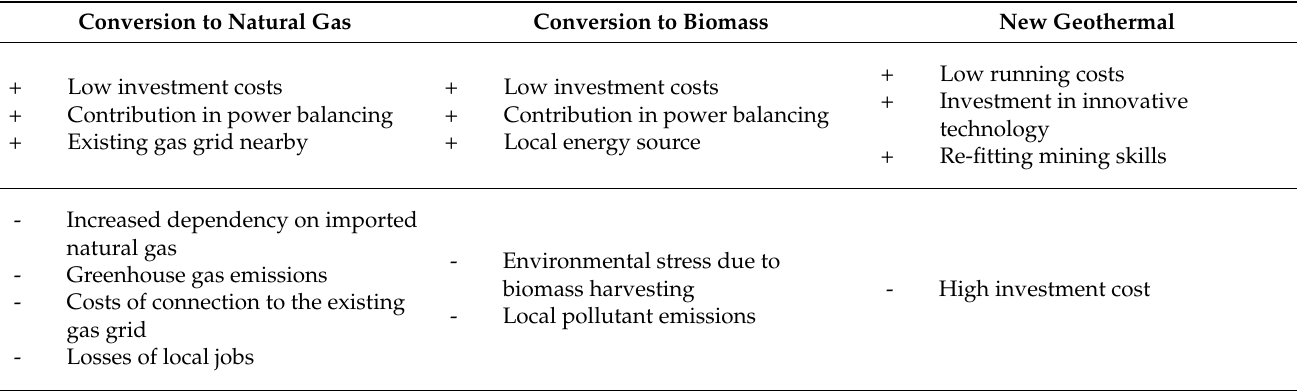
Table 3. The main pros and cons of the proposed alternative scenarios. Conversion to Natural Gas Conversion to Biomass New Geothermal Low investment